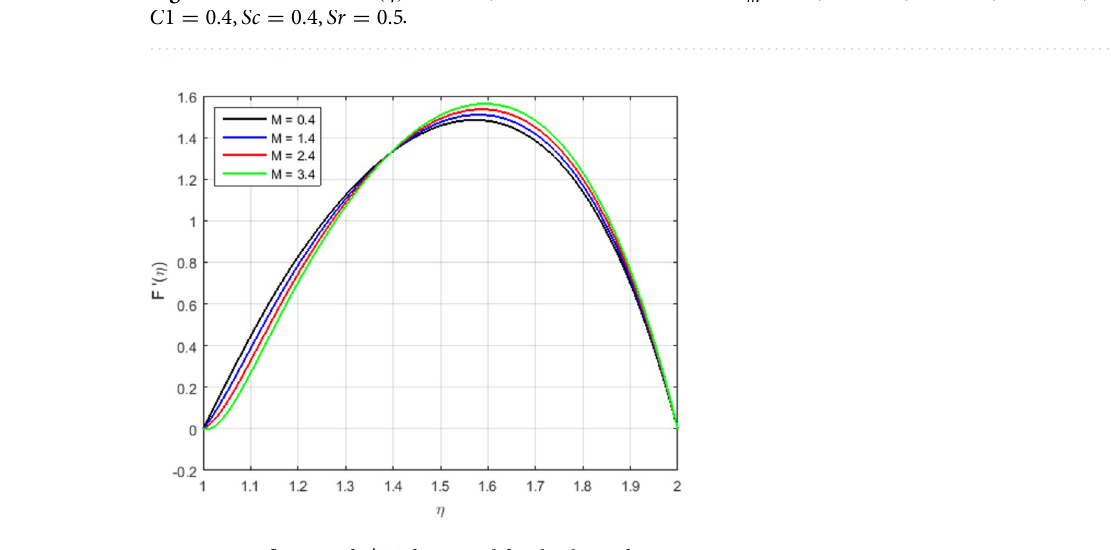
Figure 4. Influence of F ′ (η) for M and fixed values of S = 2.5, Pr = 6.2, Ec = 0.5, δ = 0.4, (cid:31)